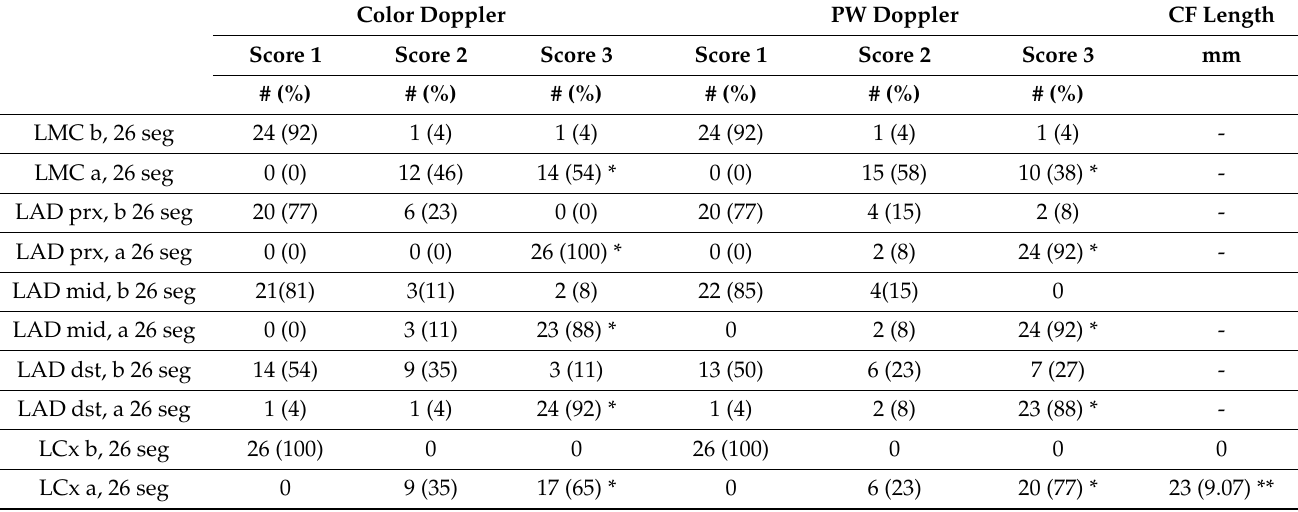
Table 2. Color Doppler quality in LMCA, LAD and LCx, before and after heart rate lowering. Color